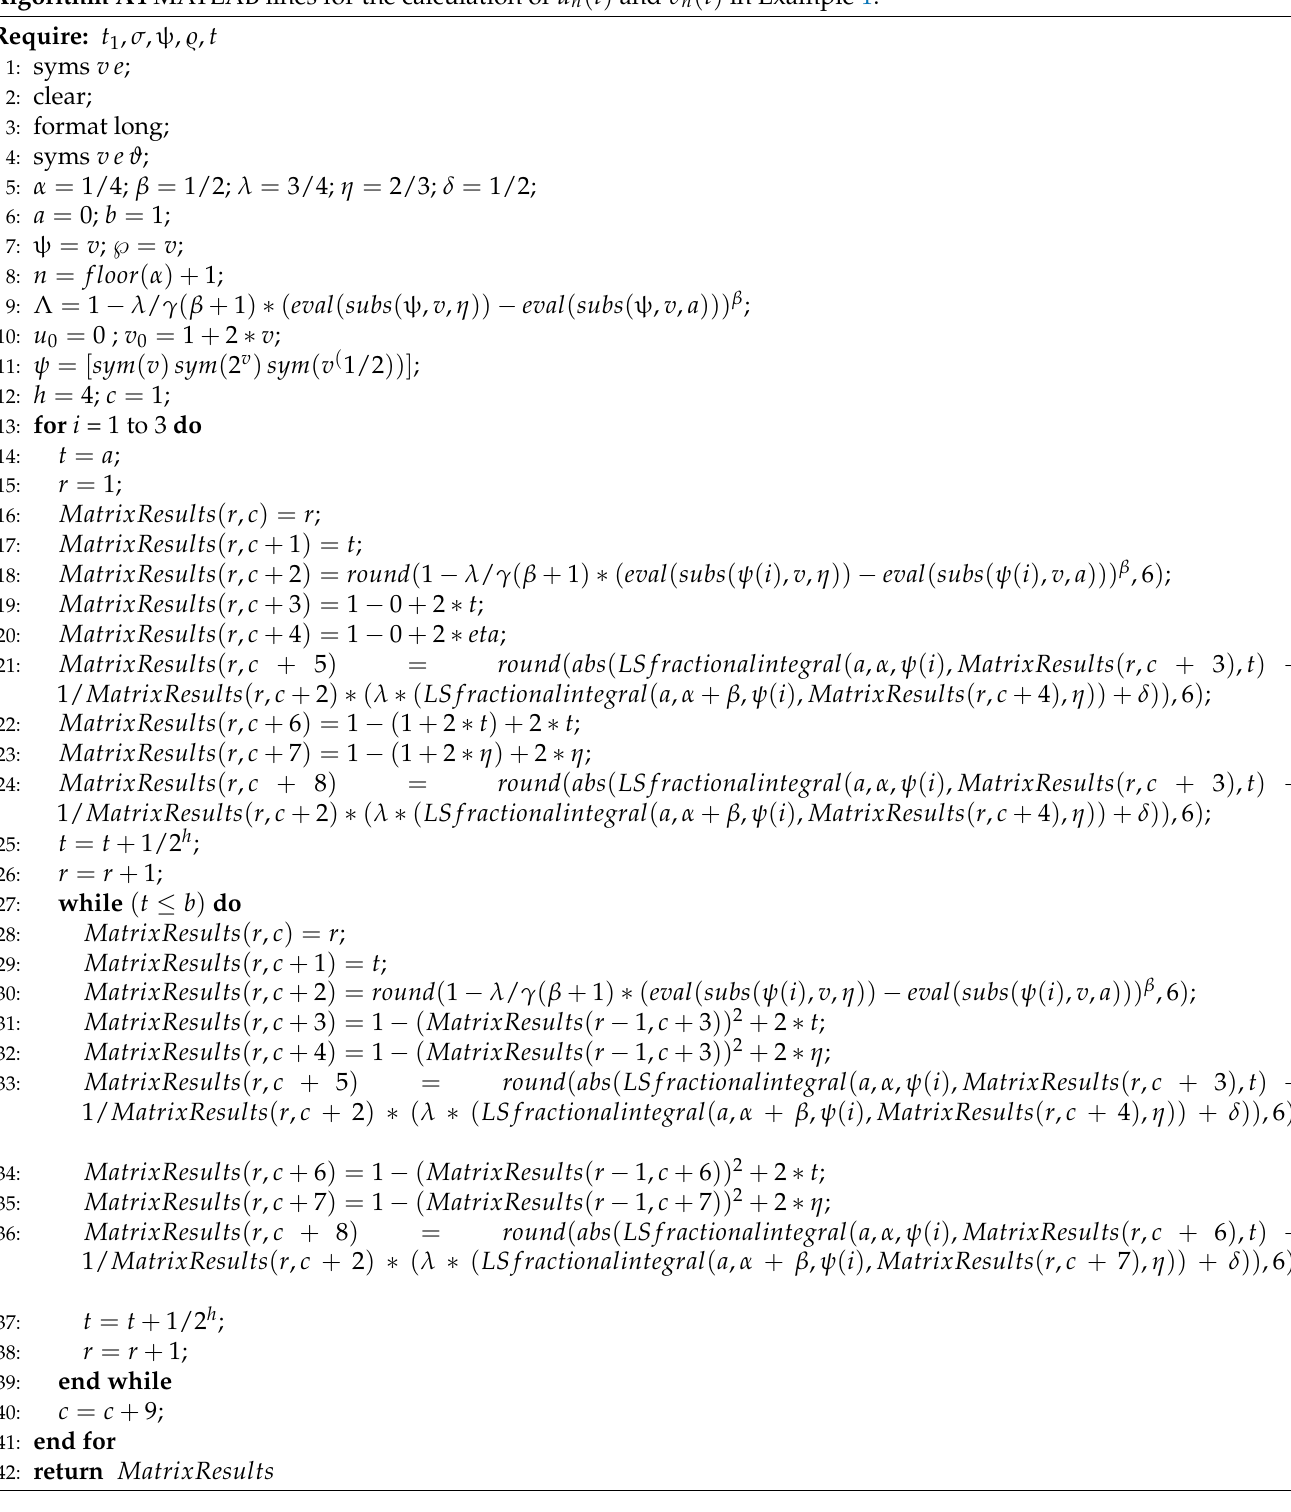
Algorithm A4 MATLAB lines for the calculation of u n ( t ) and v n ( t ) in Example